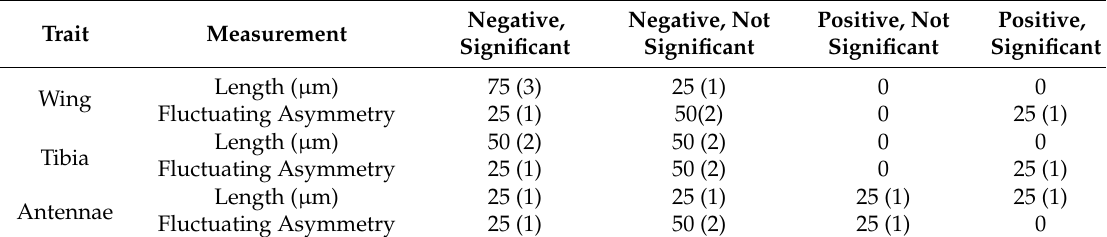
Table 3. Summary of the response parameters (percentages) of the effects of transgenic maize containing Cry1Ab on parasitoids of two African stem borer species. Increase in fluctuating asymmetry was considered a negative consequence (number of cases in